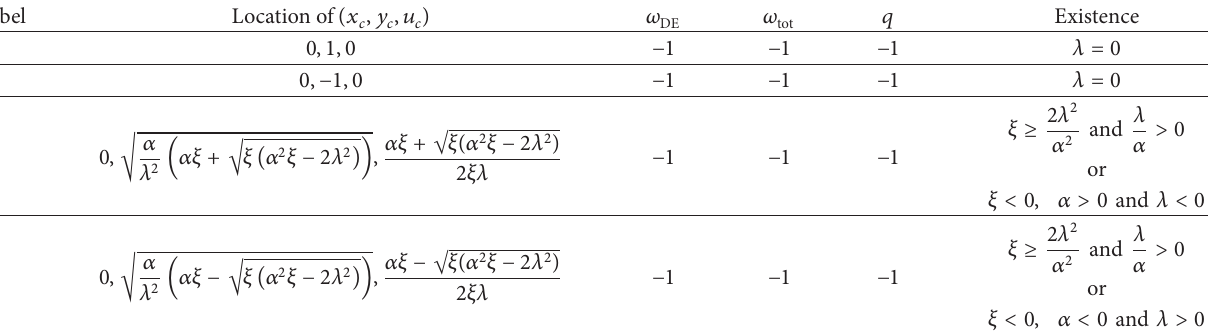
Table 1: Location and existence conditions of the critical points and the corresponding values of the dark energy equation of state parameter 𝜔 , of the total equation of state parameter 𝜔 DE